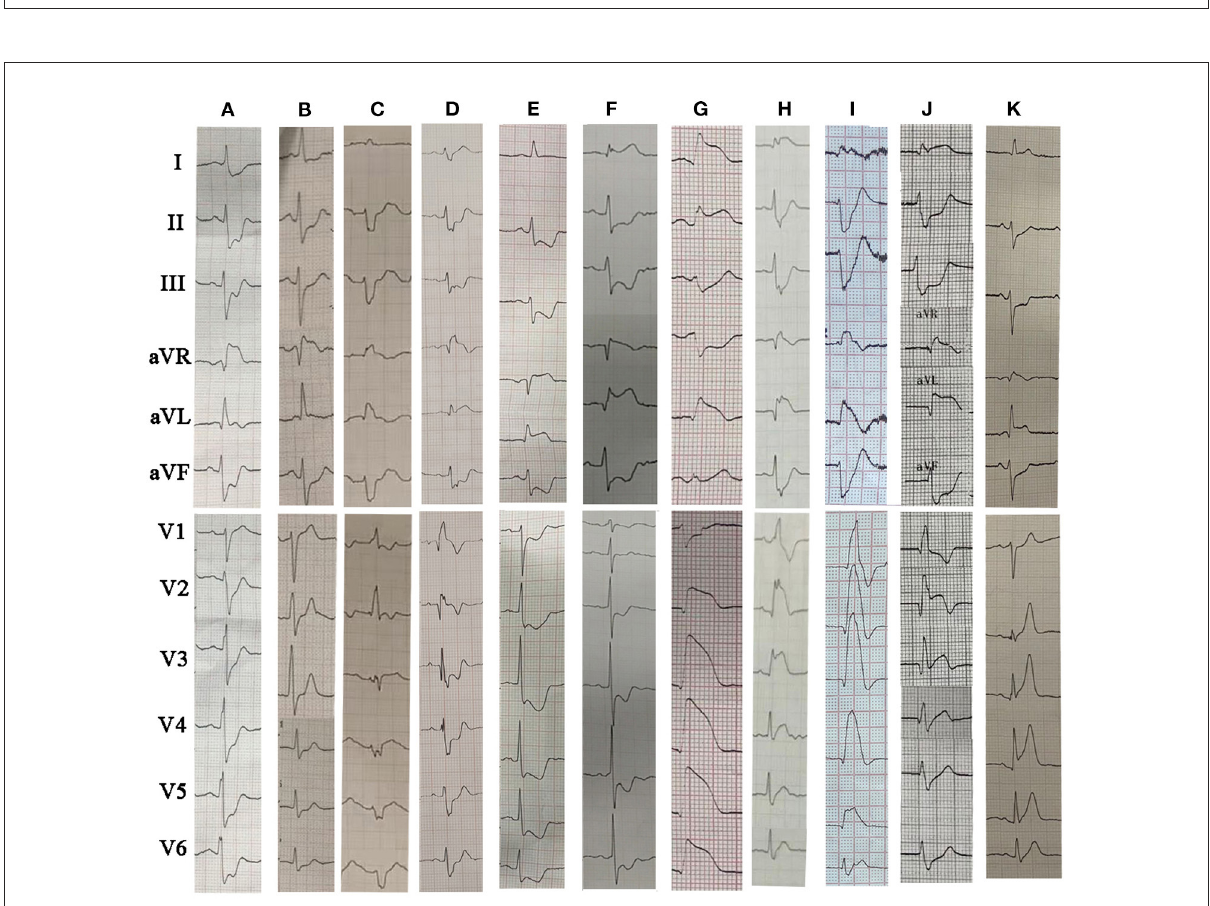
FIGURE2 The representative 12-lead ECGs for different ECG patterns in LM occlusion. (A) STE in aVR; (B) STE in aVR + V1; (C) STE in aVR plus LAFB + RBBB; (D) STE in aVR + aVL plus RBBB; (E) STE in aVR + aVL; (F) STE in I, aVL and aVR plus LAFB; (G) STE in I, aVL, V2–V6; (H) STE in I, aVL, V2–V6 plus LAFB + RBBB; (I) STE in I, aVL, V1–V6 plus LAFB + RBBB; (J) STE in I, aVL, aVR and V2–V3 (collateral filling of the LAD territory); (K) STE in I, aVL, aVR, V2–V6 plus LAFB. LM, left main coronary artery; STE, ST-segment elevation; RBBB, right bundle branch block; LAFB, left anterior fascicular